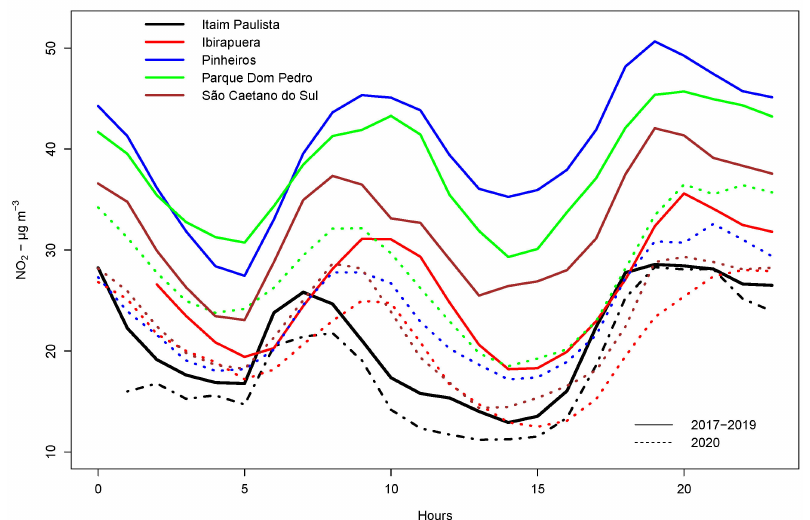
Figure 9. NO 2 hourly concentration for MASP during April–May 2017–2019 (pre-pandemic) and 2020 (during the pandemic) from ground-level